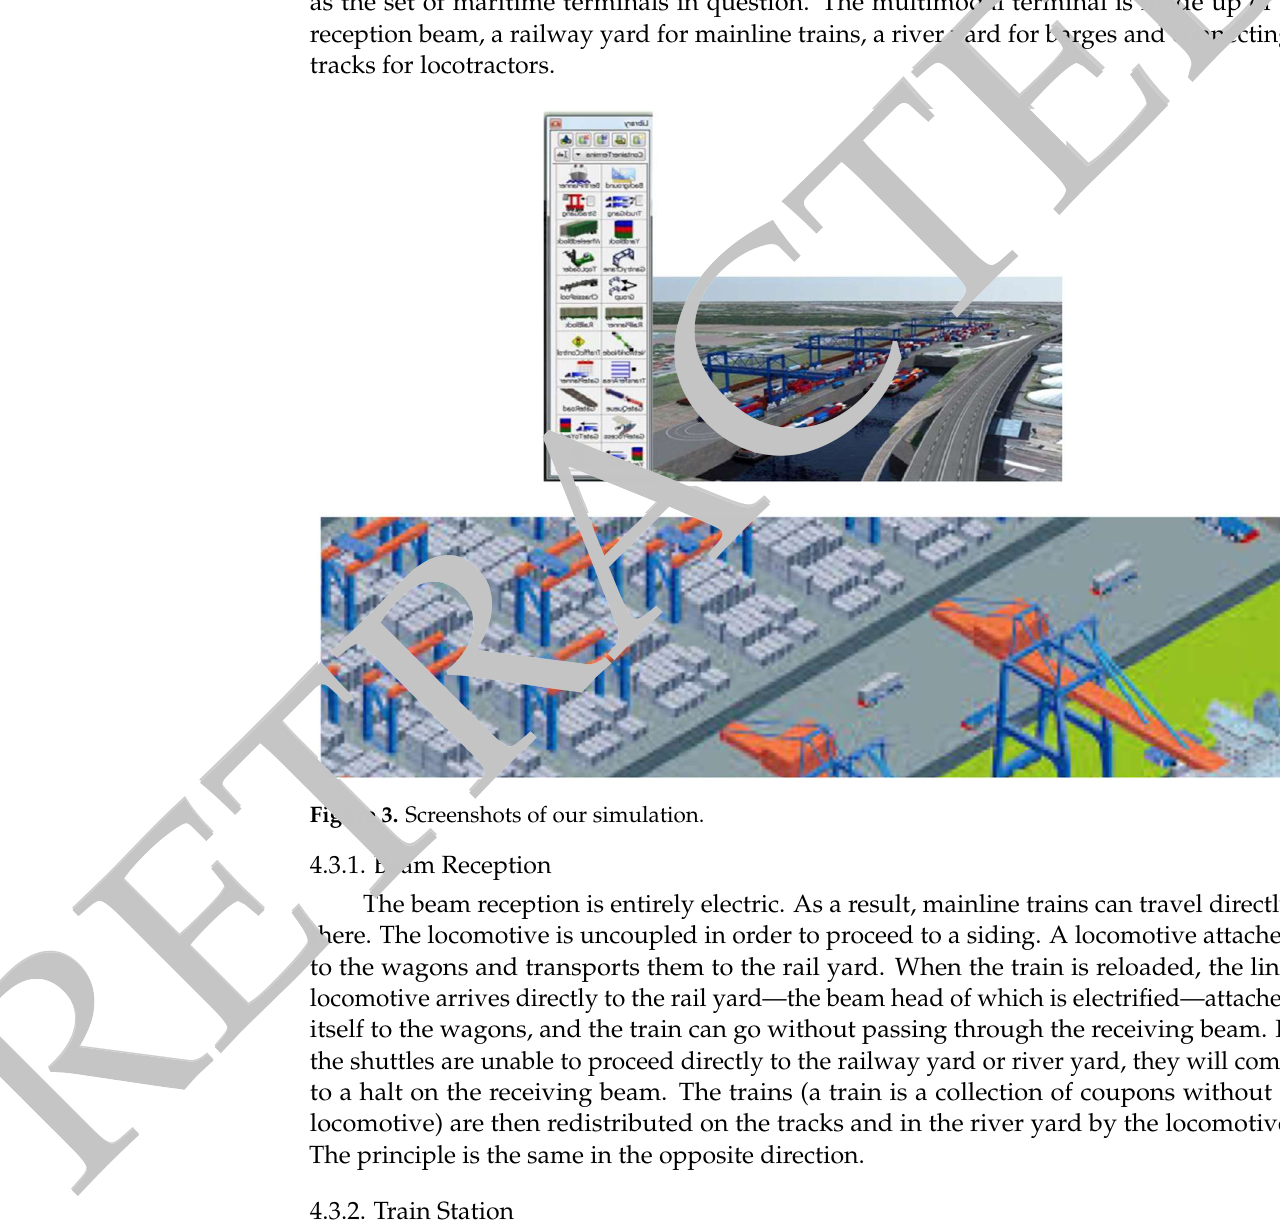
Figure 2. Explanatory diagram.